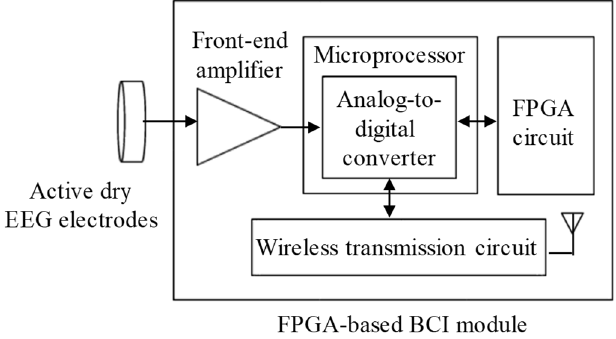
Figure 4. Block diagram of field-programmable gate array (FPGA)-based SSVEP BCI module.